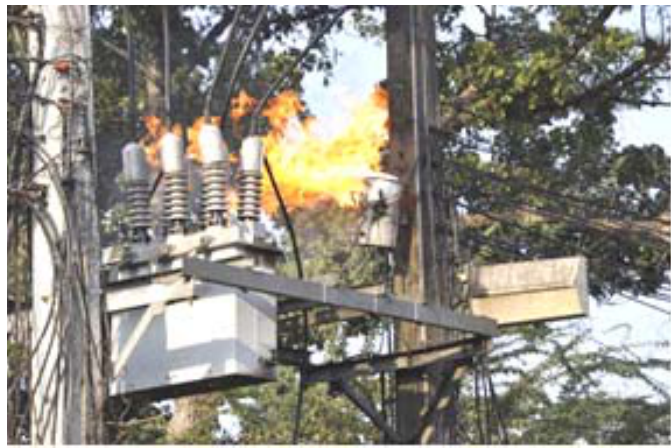
Figure 1. The transformer explosion caused in middle voltage (MV) [16].